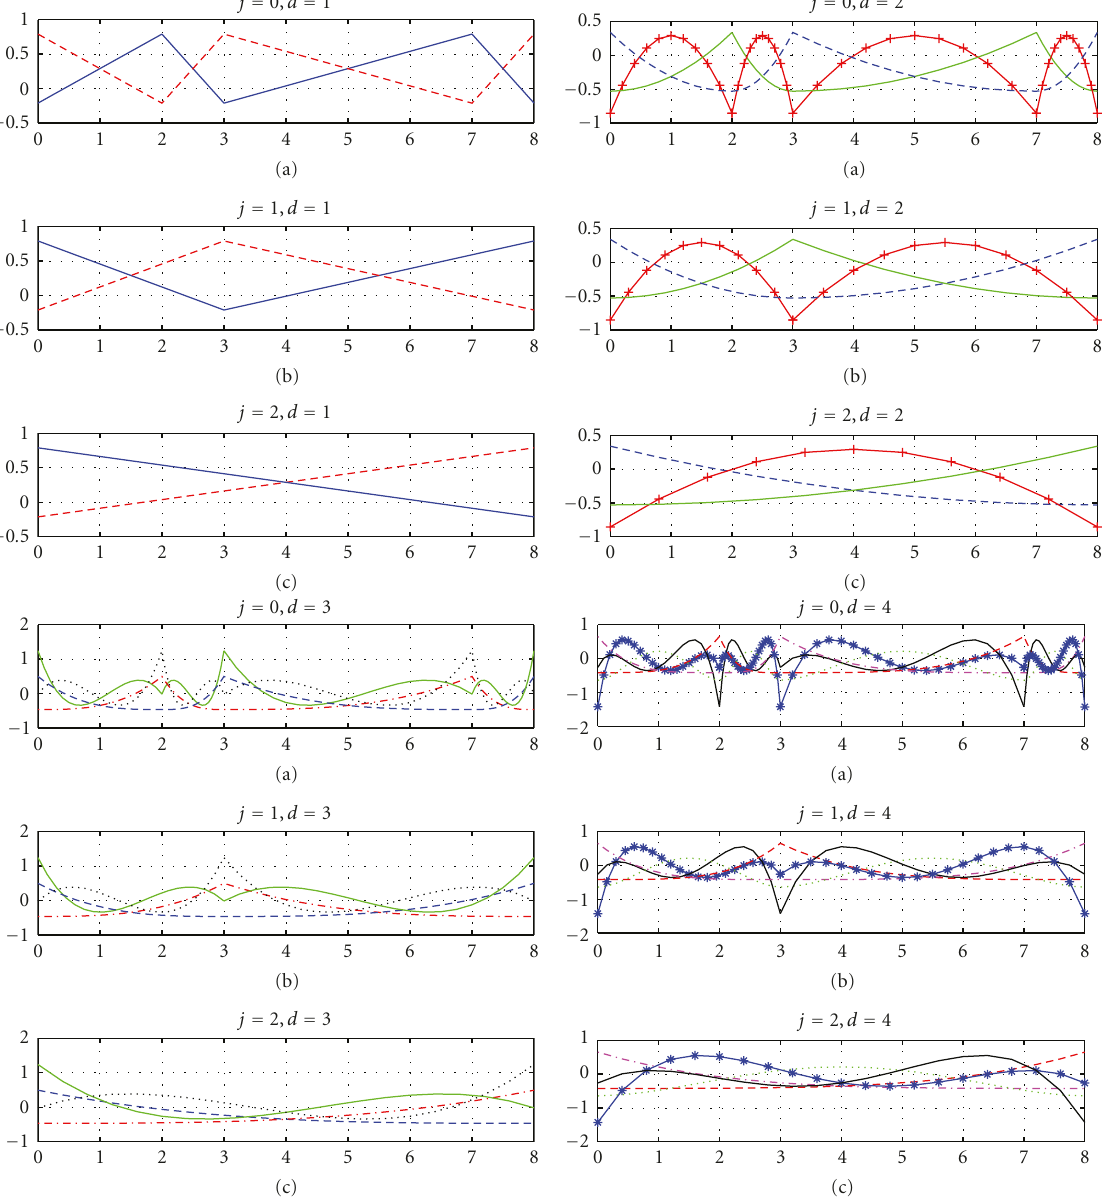
Figure 5: Orthonormal scaling spline bases at resolution levels j = 0,1,2 from top to bottom d = 1 (top left graphs), d = 2 (top right graphs) d = 3 (bottom left graphs), and d = 4 (bottom right graphs) on the finest sequence S 0 =